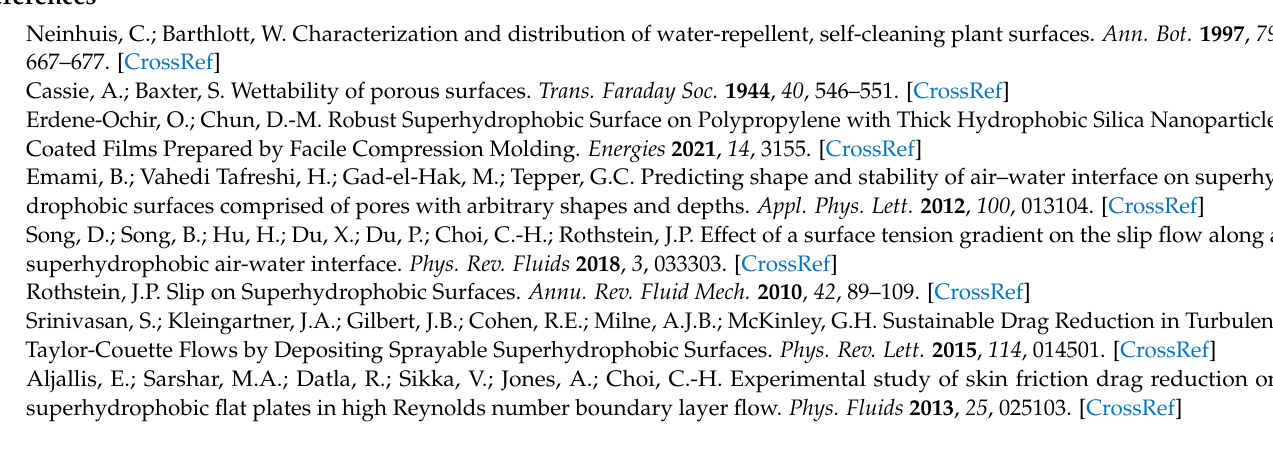
Figure 10. Effect of impacting velocity on the droplet cutting process. The mesh is NO. 2. Scale bar is 3 mm.